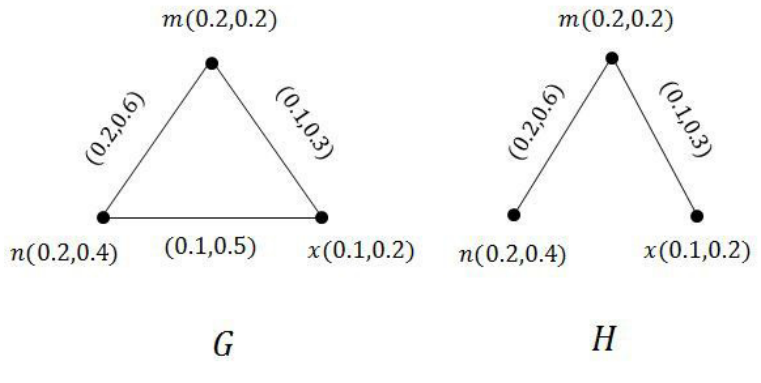
Figure 5. VG ( G ) and vague subgraph ( H ).